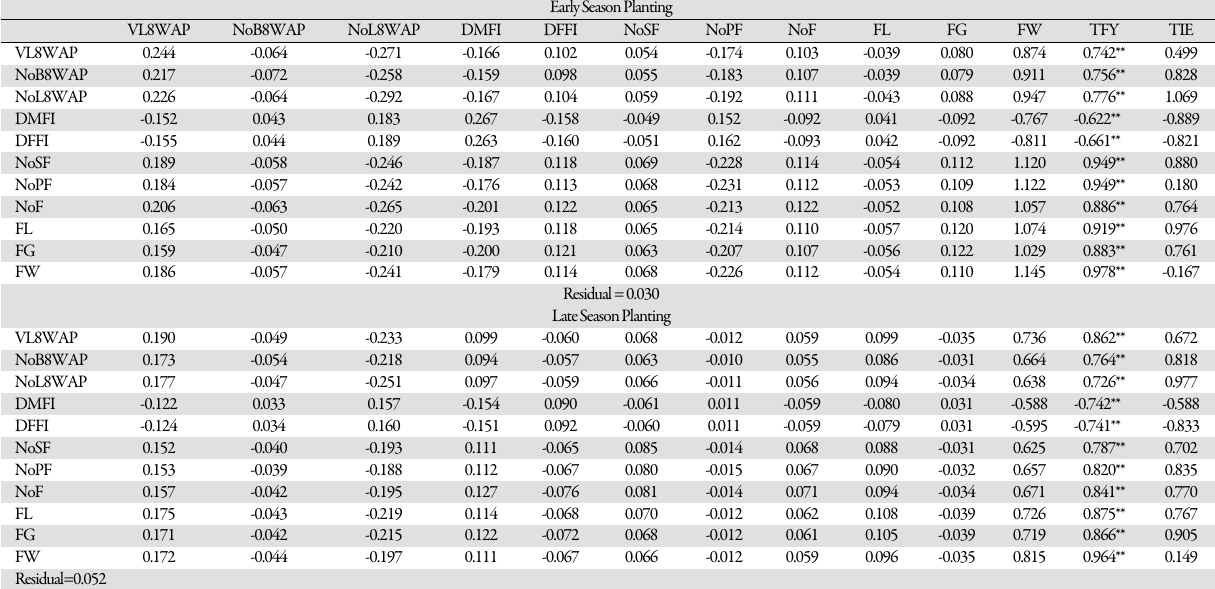
Table 8. Direct and indirect effects of traits on yield in cucumber genotypes evaluated in 2014 both early and late planting